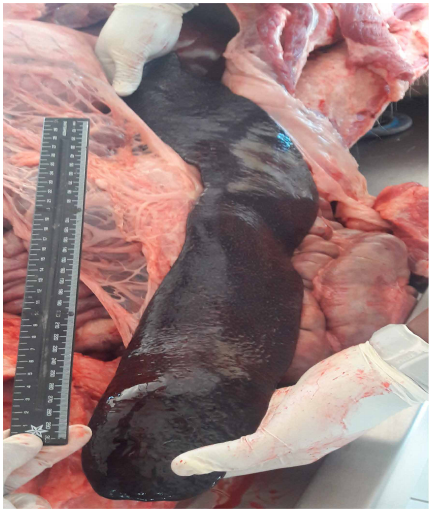
Figure 7: A very enlarged spleen in excess of 30 cm in length.